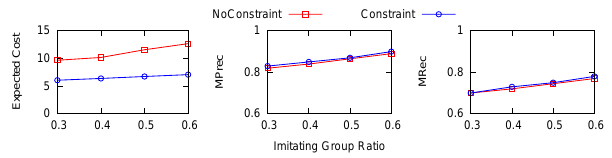
Figure 13. Effects of imitating groups on answer